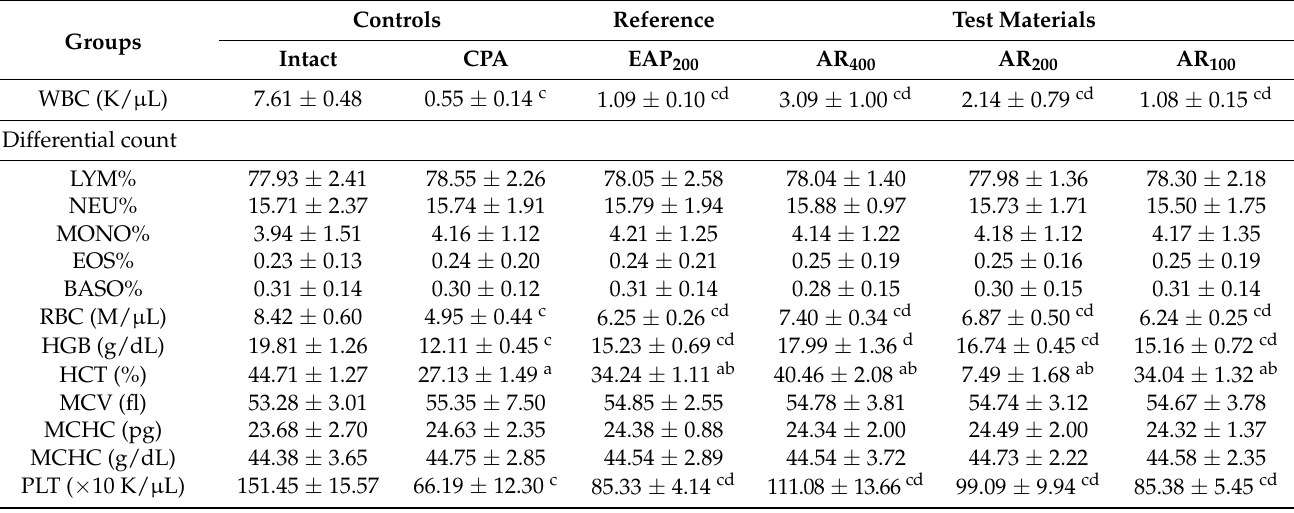
Table 4. Hematological values in intact and CPA-induced immunosuppressed mice.